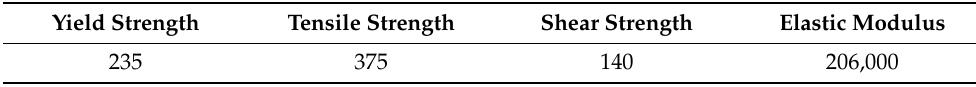
Table 3. Basic mechanical parameters of steel (unit: MPa).